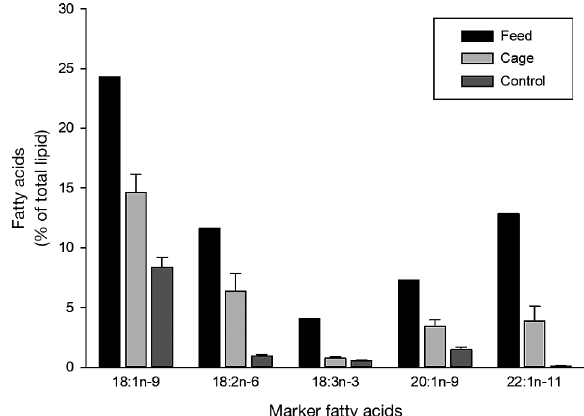
Fig. 3. Contribution of selected fatty acids (% of total lipid, mean ± SD) to the total fatty acid content in the lobster tissue at the end of the experiment (March 2019) at the control and cage sites. Feed levels are included for reference